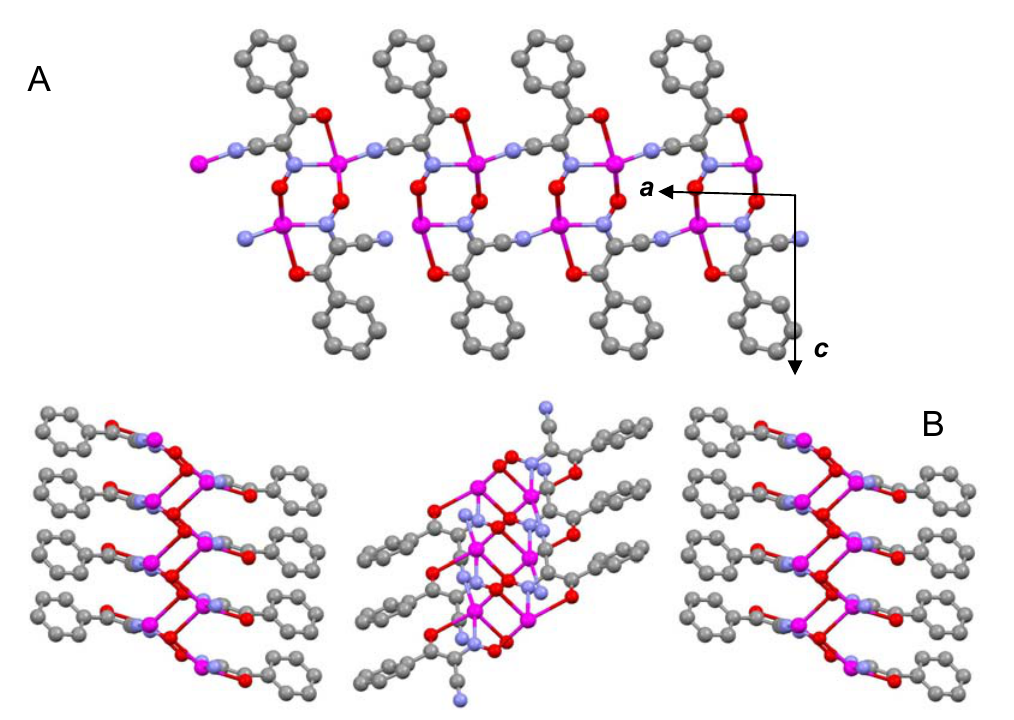
Figure 15. Organization of layered 2D structure of Ag(BCO): view of two unit cells along b showing polymeric motif ( A ), and ab diagonal view of two unit cells ( B ). H-atoms are omitted for clarity.